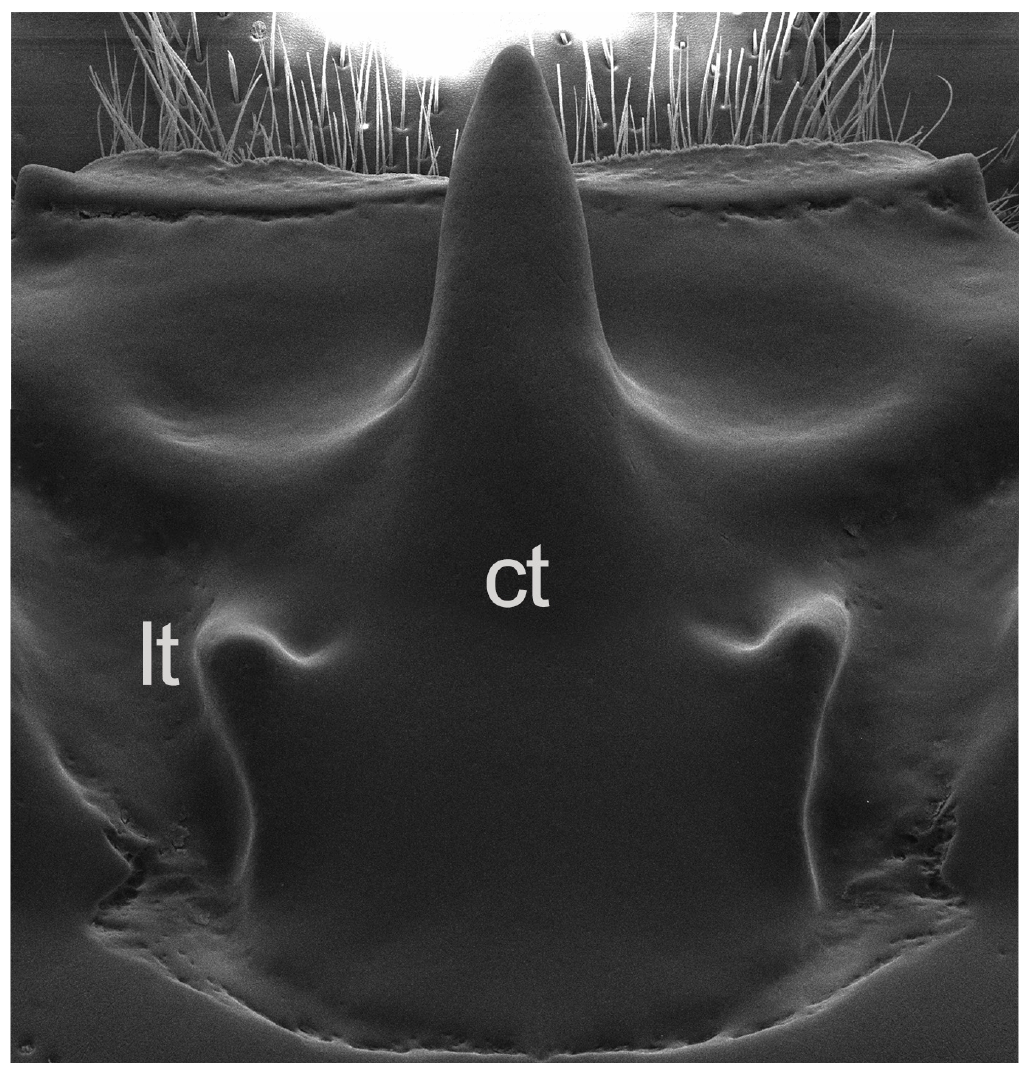
Figure 4. Scanning electron micrograph of the MFS type tepetl . Acronym list, ct = central tubercle, lt = lateral tubercles [5], later-posterior tubercles [1].